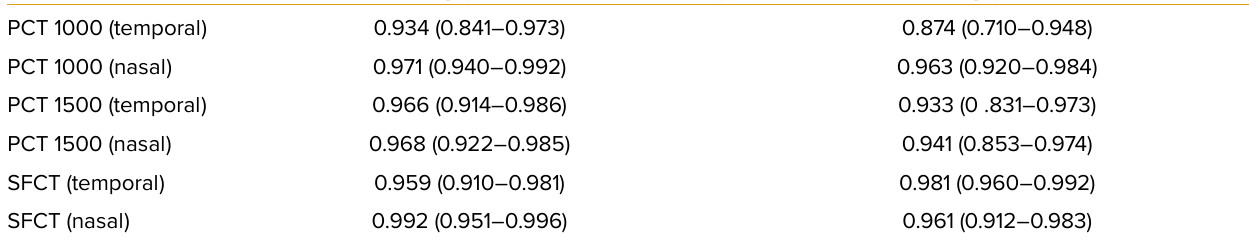
Table 2. Intraclass correlation coefficients for PCT and SFCT in a random subset of 15